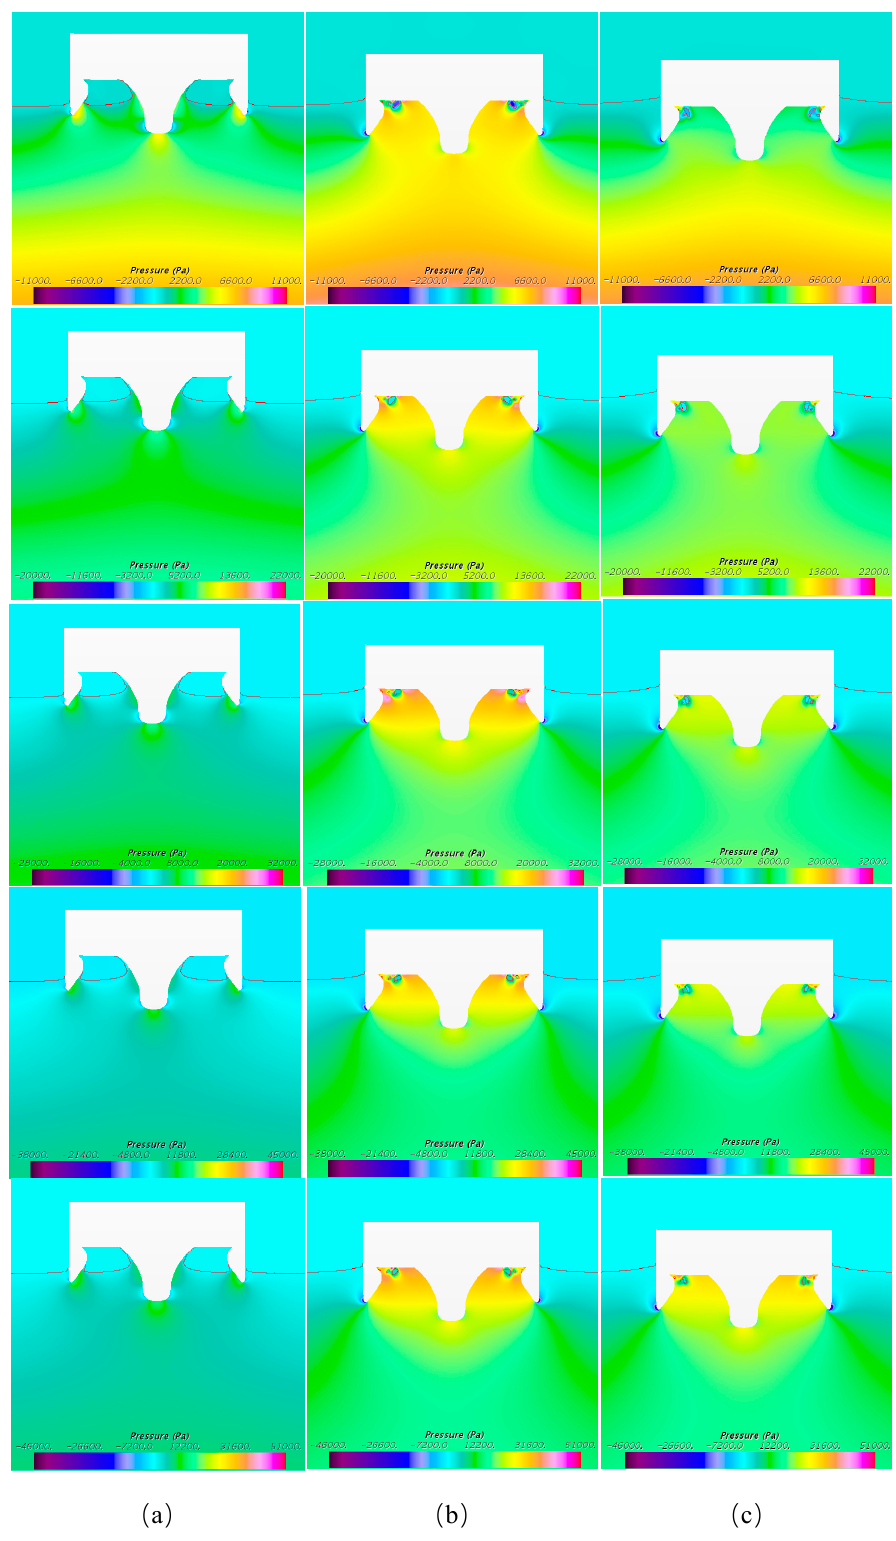
Figure 8. The pressure contours at the same penetration depth under different entry acceleration, Table 2. g, − g, 0, g, and 2 g in order; columns ( a – c ) correspond to the penetration of 0.089 m, 0.155 m, and 0.178 m, respectively).